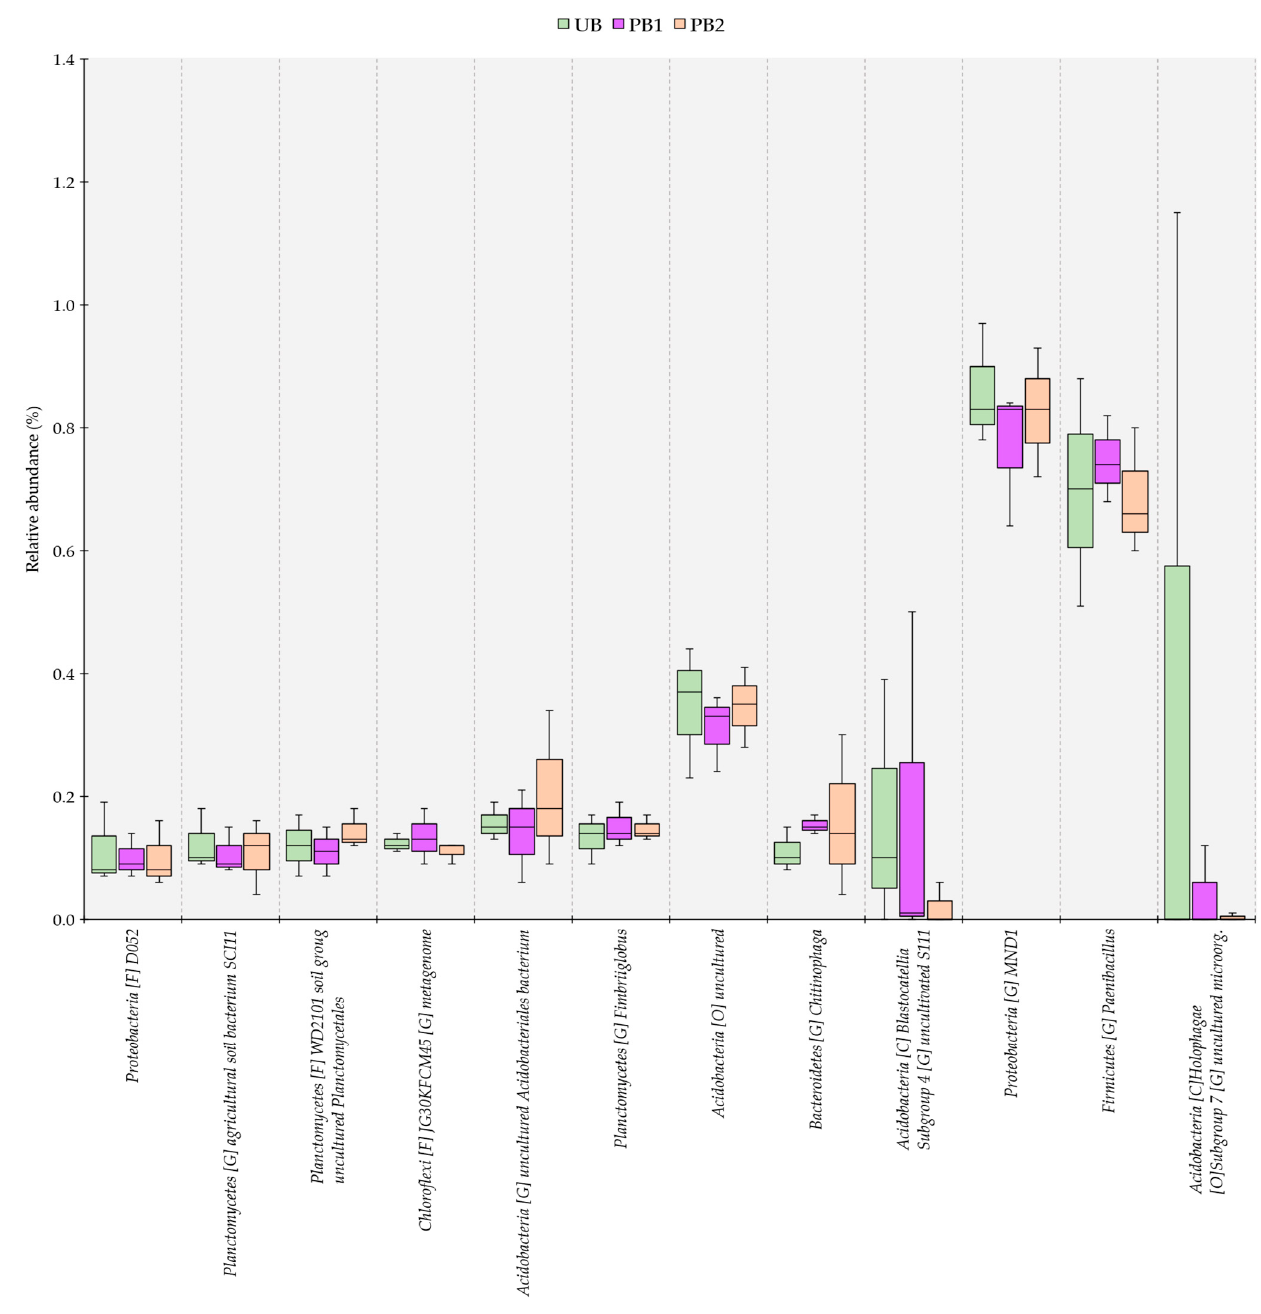
Figure 9. Bacterial taxa showing no change in relative abundance (%) after a prescribed burning treatment, regardless of the time since the application of the burn. UB: control; PB1: soils treated with prescribed burning seven months before sample collection; PB2: soils treated with prescribed burning immediately prior to sample collection Boxes include 50% of the data between the first and third quartiles (interquartile range) and the central line, the median. The whiskers include those values that deviate from the first and third quartiles up to a maximum distance of 1.5 times the interquartile range. Capital letters in square brackets indicate the lowest taxonomic level of classification: [O]: order, [C]: class, [F]: family, [G] genus.